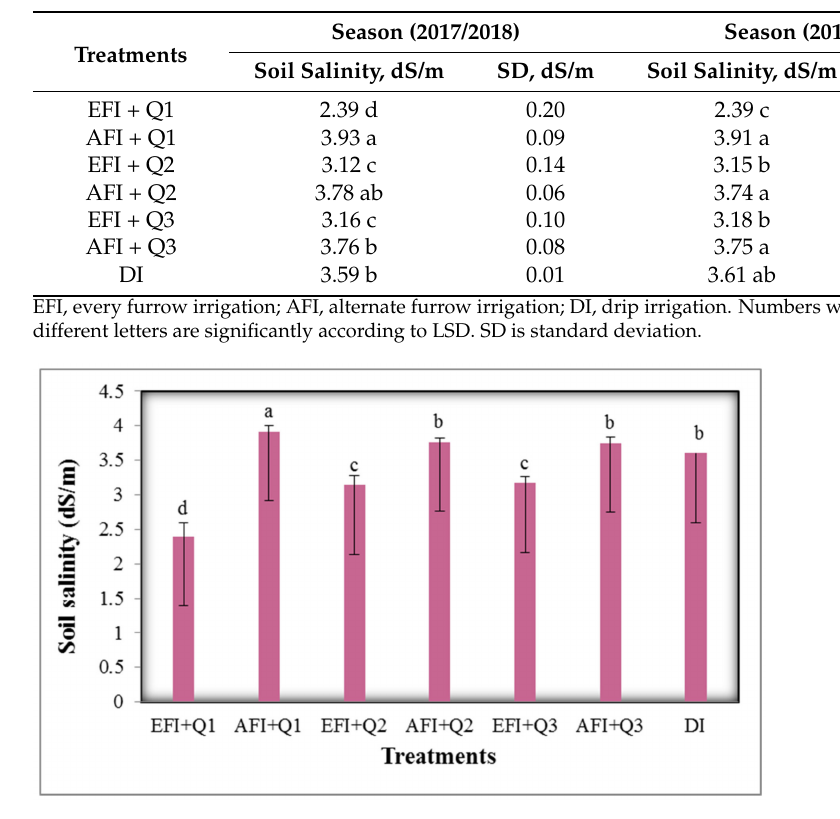
Figure 7. Effect of irrigation method (EF, AF, and DI) and flow rate (0.47 (Q1), 0.95 (Q2), and 1.43 L/s (Q3)) on soil salinity after cauliflower harvesting across the two years. Mean values followed by the same letter were not significantly different at the 5% level between